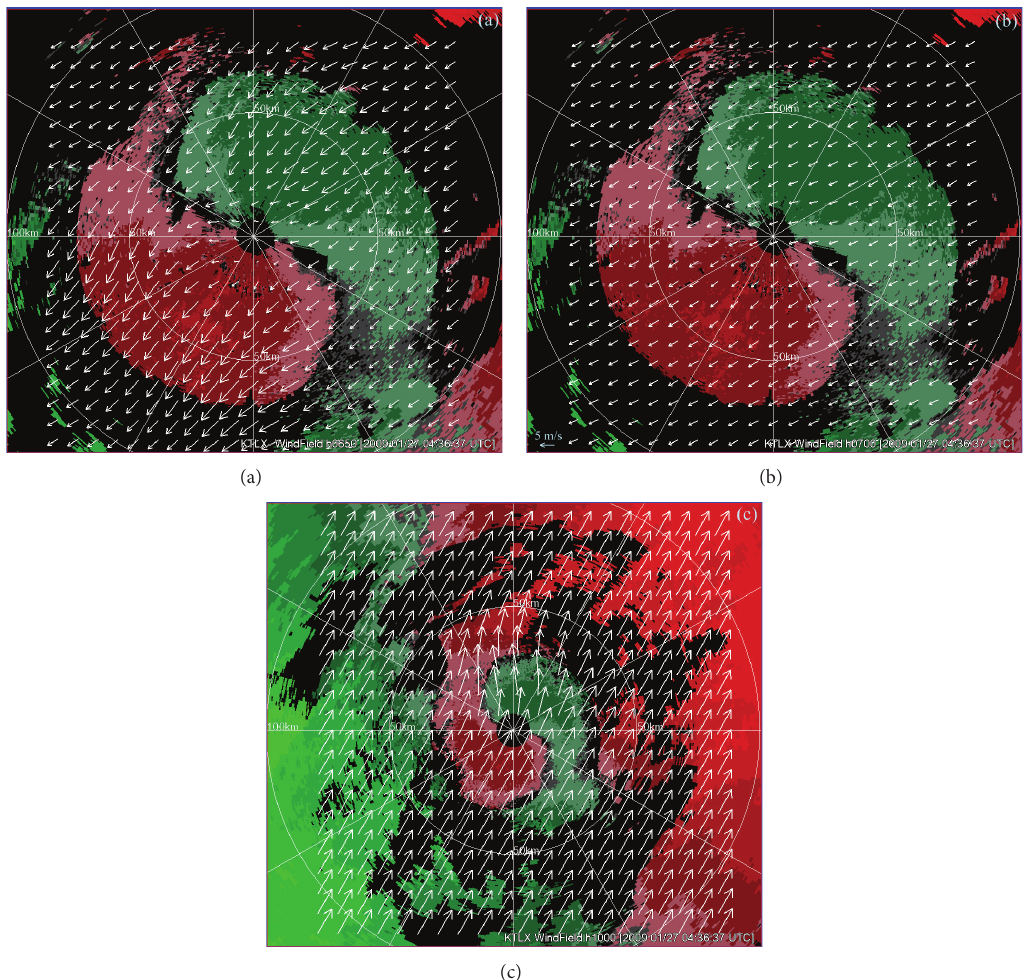
Figure 6: Horizontal winds (shown by arrows) (a) at 𝑧 = 0.7 km produced without using the shear-dependent factor in (12), (b) at 𝑧 = 0.7 km, and (c) at 𝑧 = 1km produced by using the shear-dependent factor to construct the background error covariance matrices in (10) and (11a) and (11b) for the ice storm case in Figure 4. The color images in (a) and (b) are the dealiased radial velocities at 0.5 ∘ tilt. The color image in (c) is the dealiased radial velocities at 1.5 ∘ tilt. The vector scale is the same for the three panels and is plotted at the lower-left corner of (b). The domain size is 160 × 160 × 5 km 3 . The horizontal resolution is Δ𝑥 = Δ𝑦 = 2km and the vertical resolution is Δ𝑧 = 50 m. The radial-velocity color scales are the same as those shown on the top of each panel of Figure